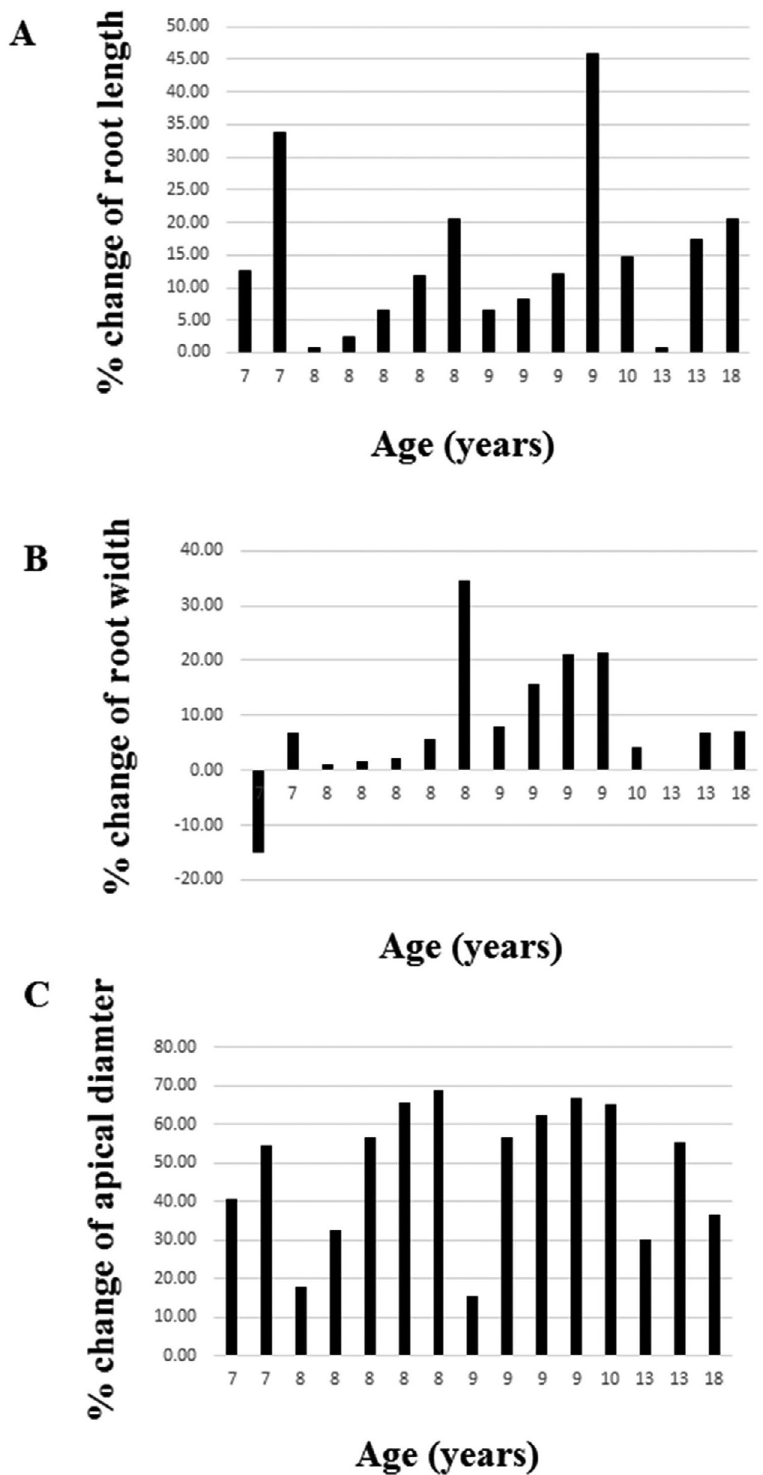
Figure 2- Patient’s age and radiographic changes in (A) increase in root length; (B) increase in root width; (C) decrease in apical